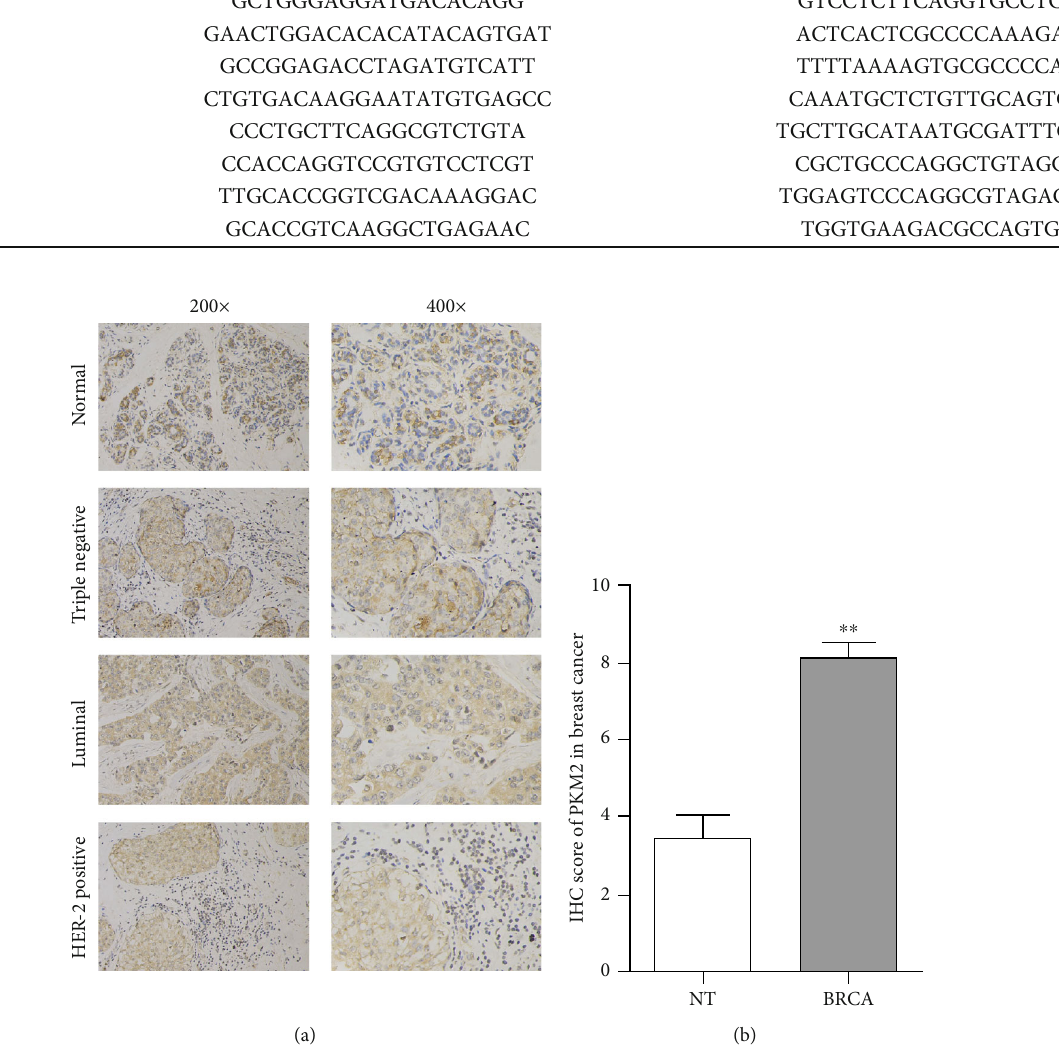
Figure 1: PKM2 is upregulated in breast cancer tissues. (a) Representative images of IHC staining of PKM2 in normal breast tissues and breast cancer tissue samples (TNBC, luminal, and HER-2 positive; × 200 and × 400 magni fi cation). (b) IHC score of PKM2 in normal tissues (NT) and breast cancer (BRCA) ( ∗∗ P < 0 : 01 ).